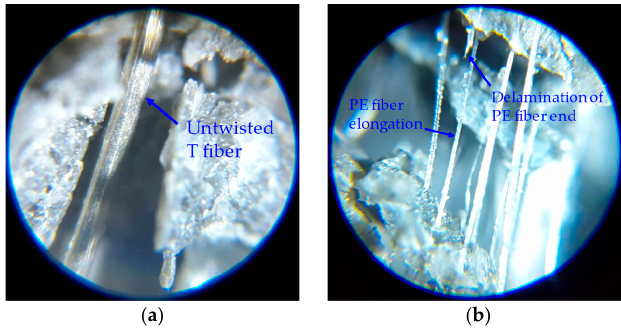
Figure 5. Microscopic images of UHPCC: ( a ) A untwisted T fiber and ( b ) elongation of LLPE